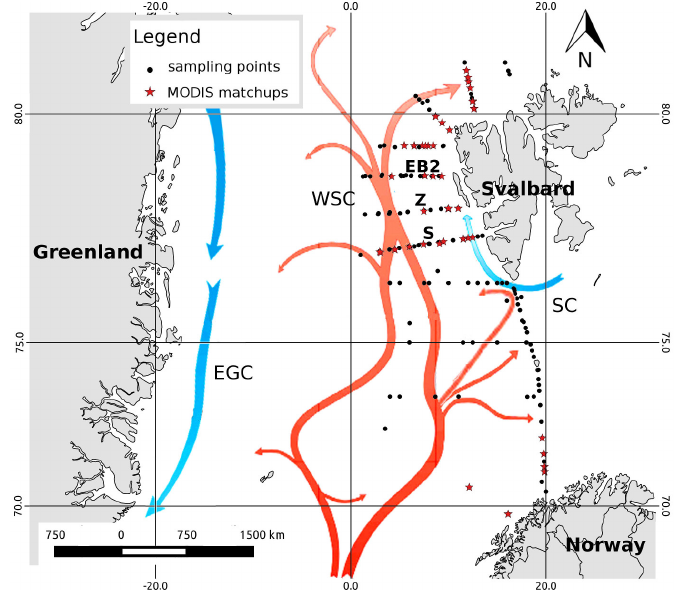
Figure 1. The main currents in Fram Strait and the Nordic Seas region with the sampling points. The cold East Greenland Current (EGC) and the Sørkapp Current (SC) marked in blue, and the warm West Spitsbergen Current (WSC) marked in red. Match-ups with chlorophyll a concentration maps from MODIS are depicted by red asterisks (modified